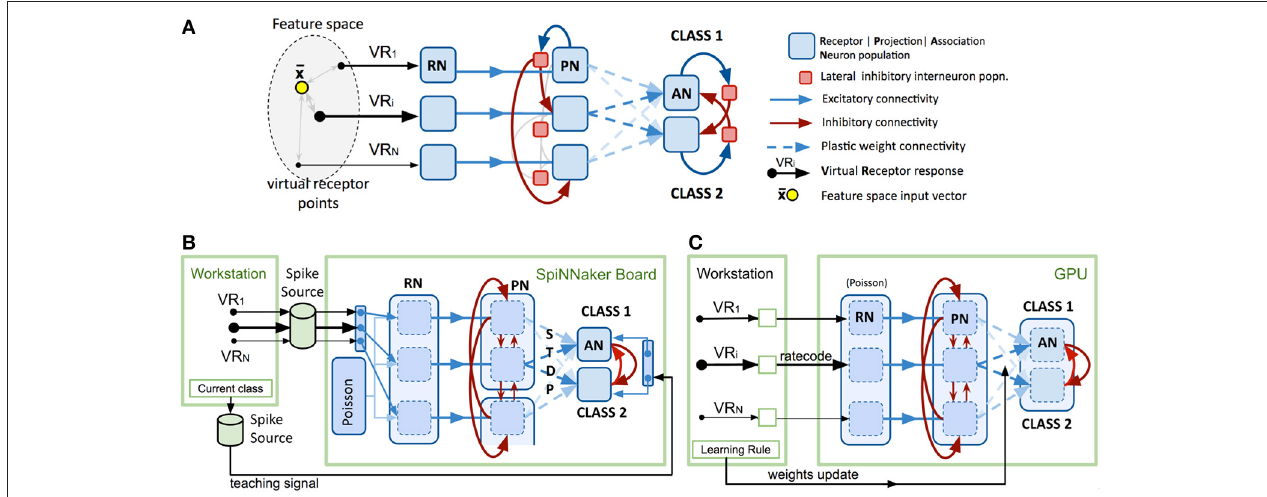
FIGURE 1 | Spiking model design and platform-specific implementations. (A) Conceptual spiking network model for a generic multivariate classifier design based on the insect olfactory system. (B) Neuromorphic implementation of the model using PyNN and SpiNNaker SpiNN-3 board. See text for functional detail. Note that spike sources comprise files generated on the host workstation then transferred to the SpiNNaker board. (C) Neuromorphic implementation of the model using GeNN and nVidia “Titan Black” GPU card. See text for functional detail. Note that the lighter arrows are included to imply the repeated sets of connections applied to the remaining permutations of population